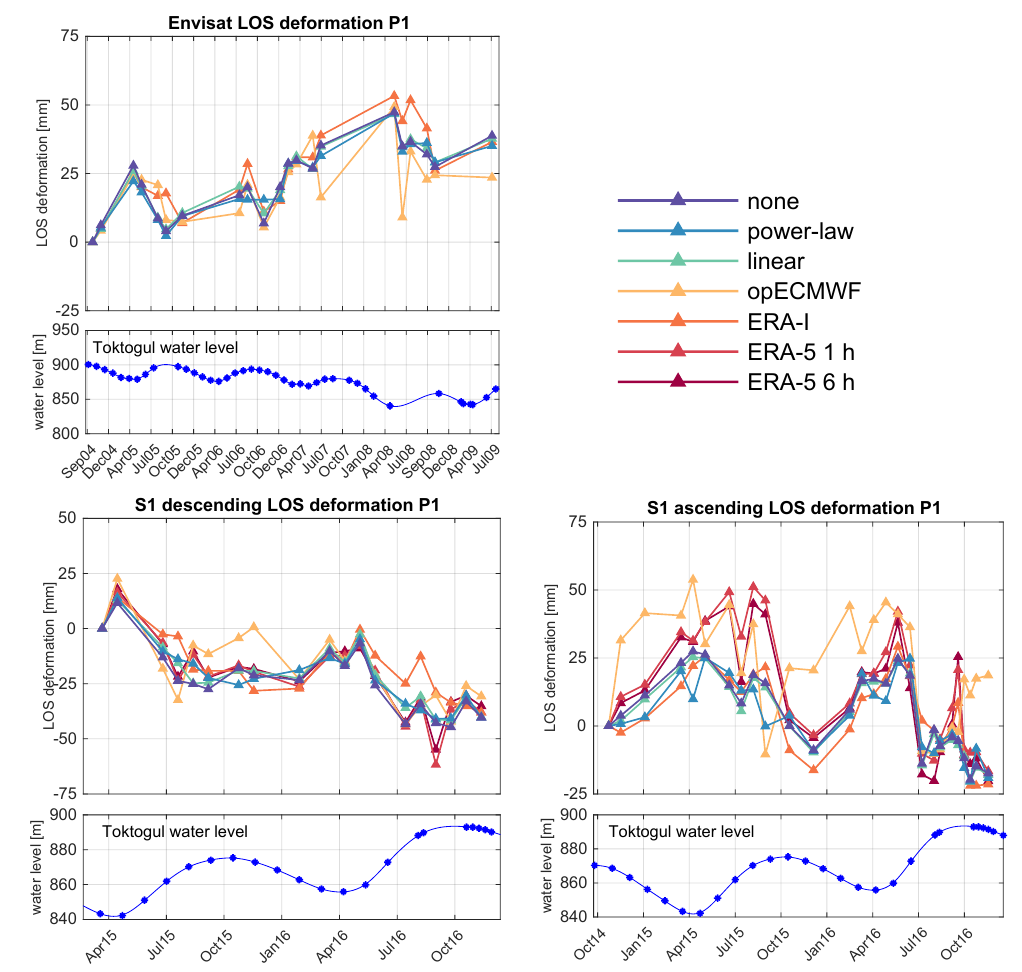
Figure 5. Variances of the LOS deformation in time for all applied atmospheric corrections. The location of the exemplary point P1 is shown in Figure6. For better visualization, deformation markers have been connected with lines, although this does not imply that we expect linear deformation in